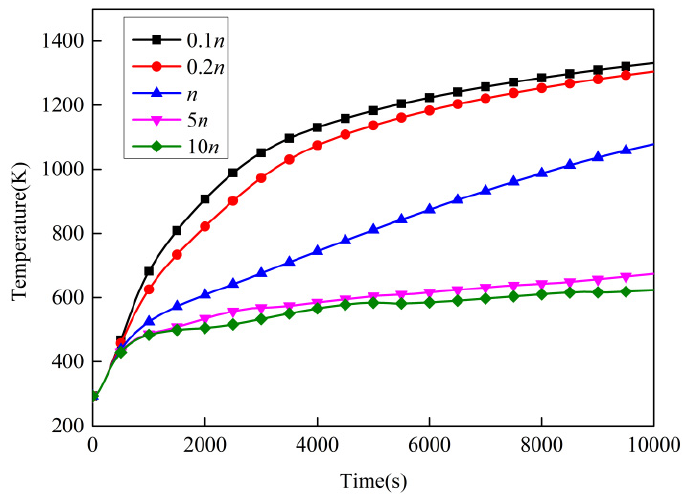
Figure 16. Temperature variation over time with different expansion rates.